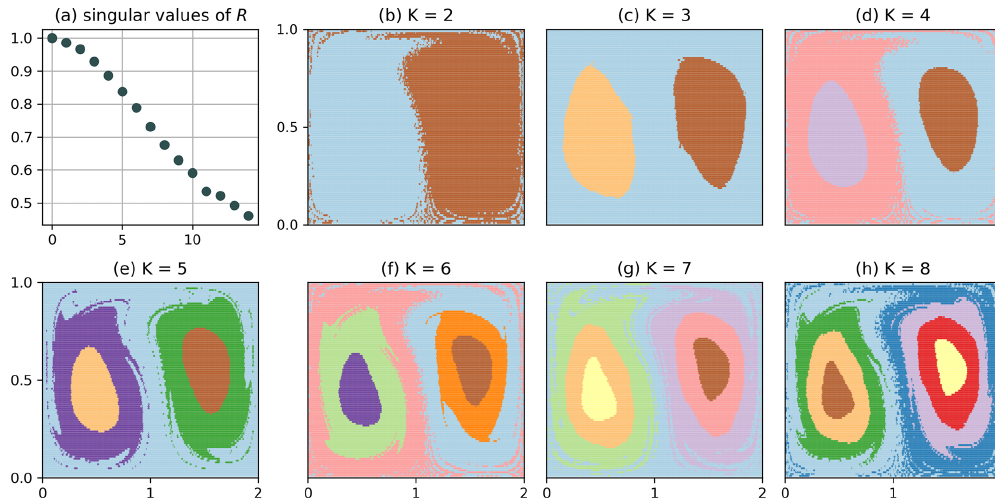
Figure 3. Clustering of Q with (cid:49)x = (cid:49)y = 0 . 04 of the full data set, i.e. N = 20000 and τ = 201.